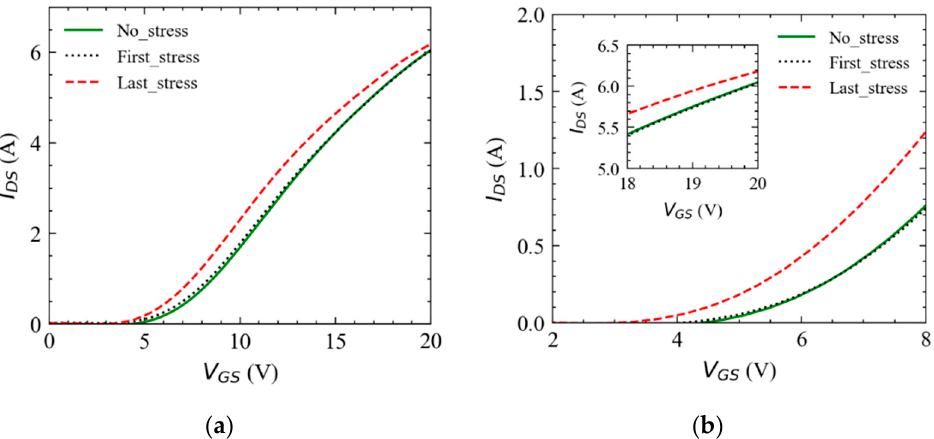
Figure 6. ( a ) I DS – V GS characteristics from which R ON and V TH were extracted. Reported curves were collected for 250 V off-state drain voltage in three different conditions: before stress (green solid lines), after the first stress period of ≈ 110 µ s (black dotted curves), and after 1000 s stress (red dashed curves). ( b ) Detail of parameters drifts: V TH moves towards the left after 1000 s of operation. The current increase observed in the triode region (see figure inset) is a signature of decreased R ON